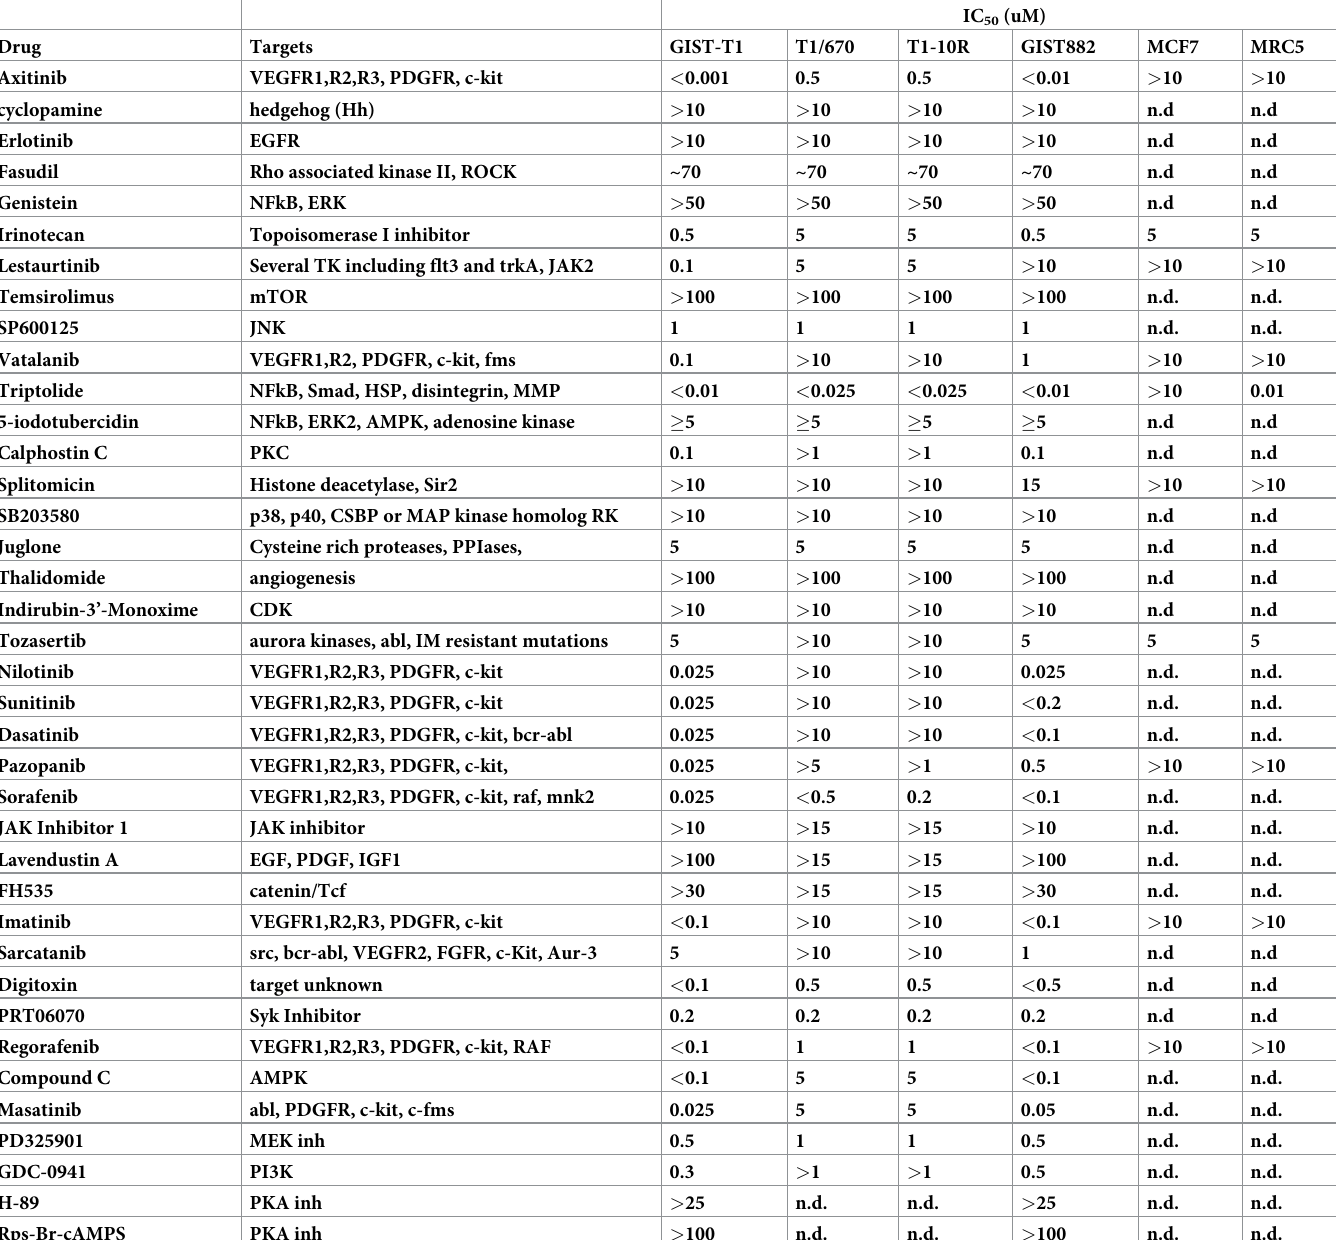
Table 1. IC50s of inhibitors used for proliferation